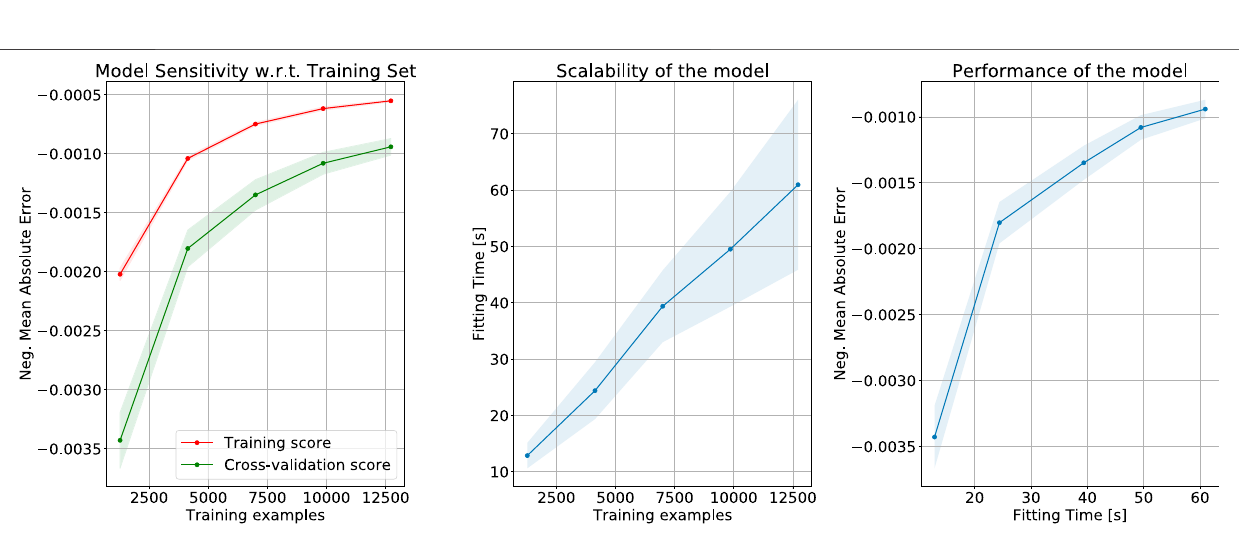
FIGURE 11 | Learning Curves of the best multivariate Random